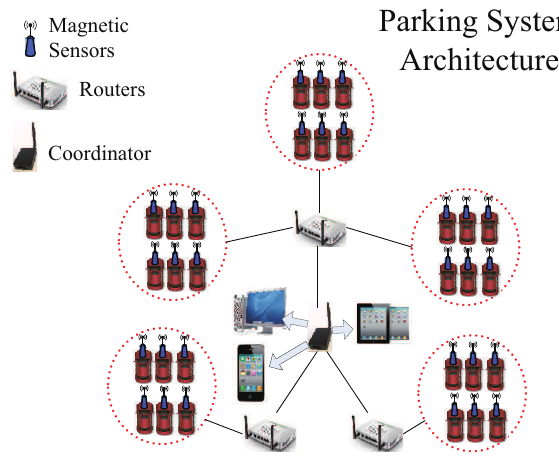
Fig. 1. Parking Space Detection System.